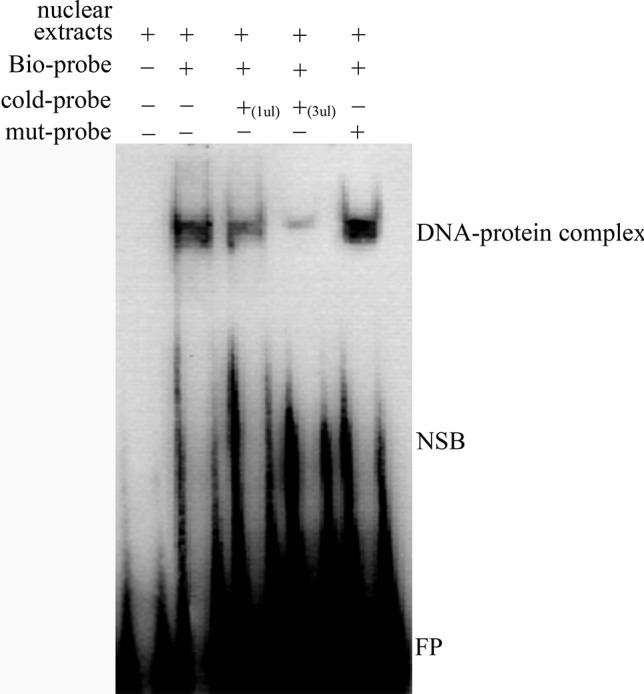
Competitive EMSA assay confirms the specific binding between MTF-1 and -700GG of the NR5A2 promoter region. Probes in this assay containing the NR5A2 -700GG site with or without biotin labeling were called bio-probes or cold probes, and probes containing the NR5A2 -700TT site without biotin labeling were called mut-probes. These probes were incubated with ovary nuclear extracts in different combinations, and DNA–protein complexes were visualized by autoradiography. FP, free probes; NSB, non-specific binding; DNA–protein complex: DNA and transcription factor MTF-1 binding complex.